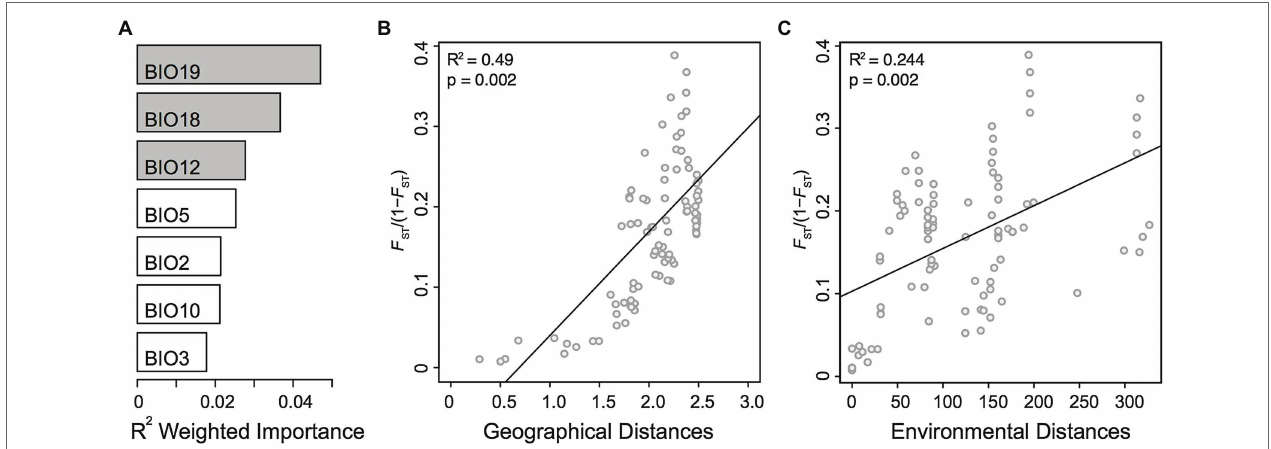
FIGURE 4 | Isolation by distance (IBD) and isolation by environment (IBE). Influence of geographical and environmental covariates on genetic differentiation in Greek populations of A. tinctoria . (A) R 2 weighted importance of environmental covariates that explains genetic gradients estimated using gradient forest. Top 3 environmental covariates are given in gray. Relationship of genetic distances ( F ST /1 − F ST ) and (B) log-transformed geographical distances, or (C) environmental distances. Analysis are based on 16,107 SNPs present across all